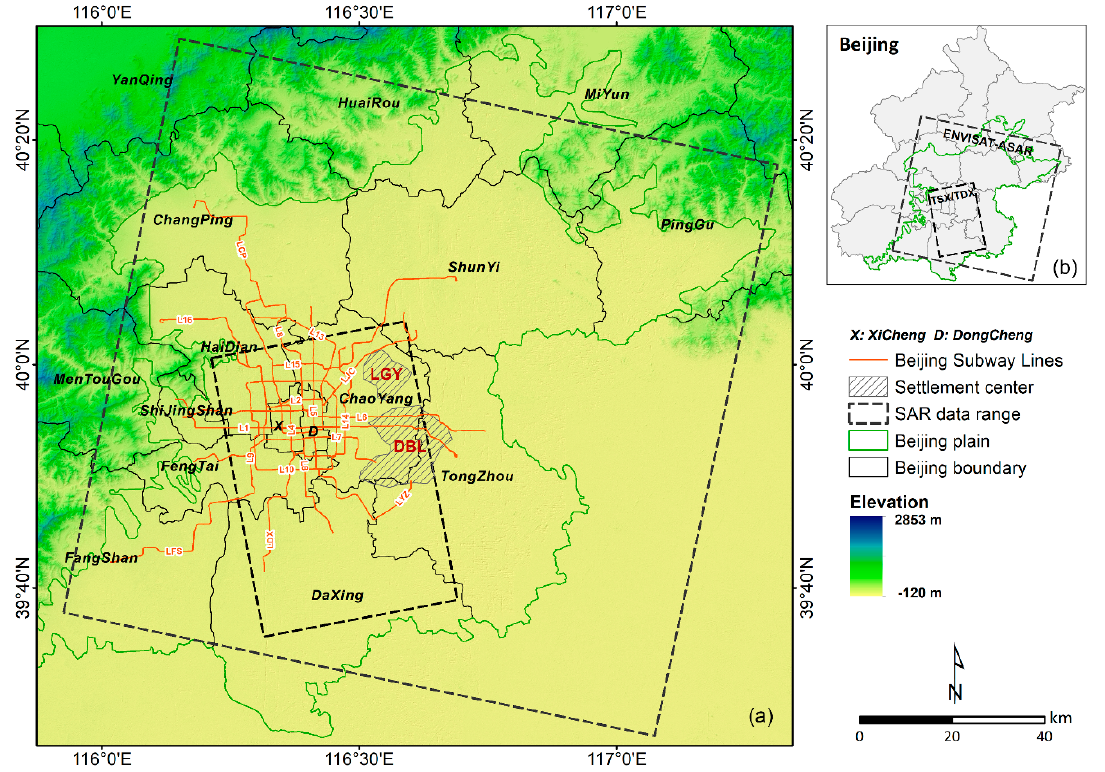
Figure 1. Location of the study area. The most serious subsidence center—comprising Laiguangying (LGY) and Dongbalizhuang-Dajiaoting (DBL)—was mapped based on previous research [24]. The orange lines represents the distribution of the Beijing Subway at the end of 2018.